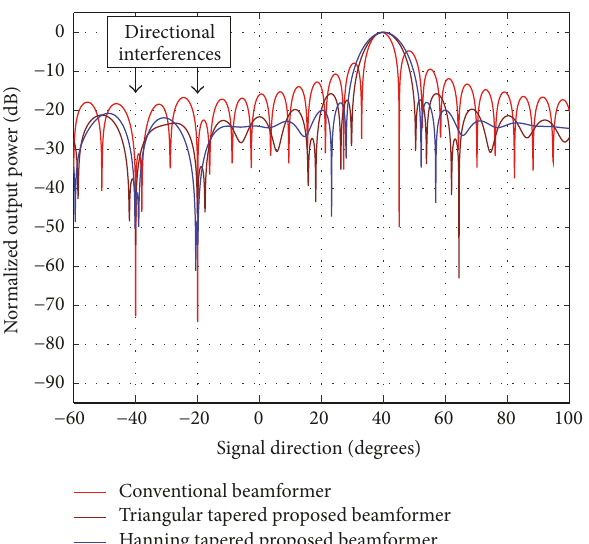
Figure 10: Normalized power pattern comparison of the proposed CECCAA beamformer with the conventional CECCAA